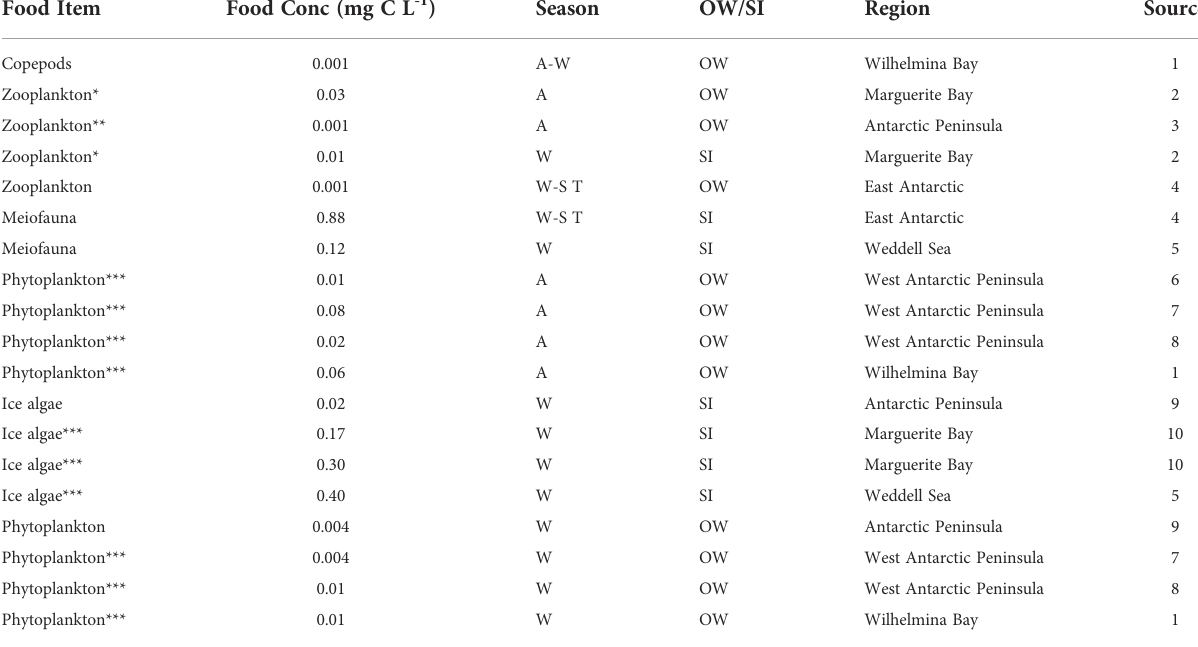
TABLE 1 Autumn and winter food availability for juvenile Antarctic krill. Food